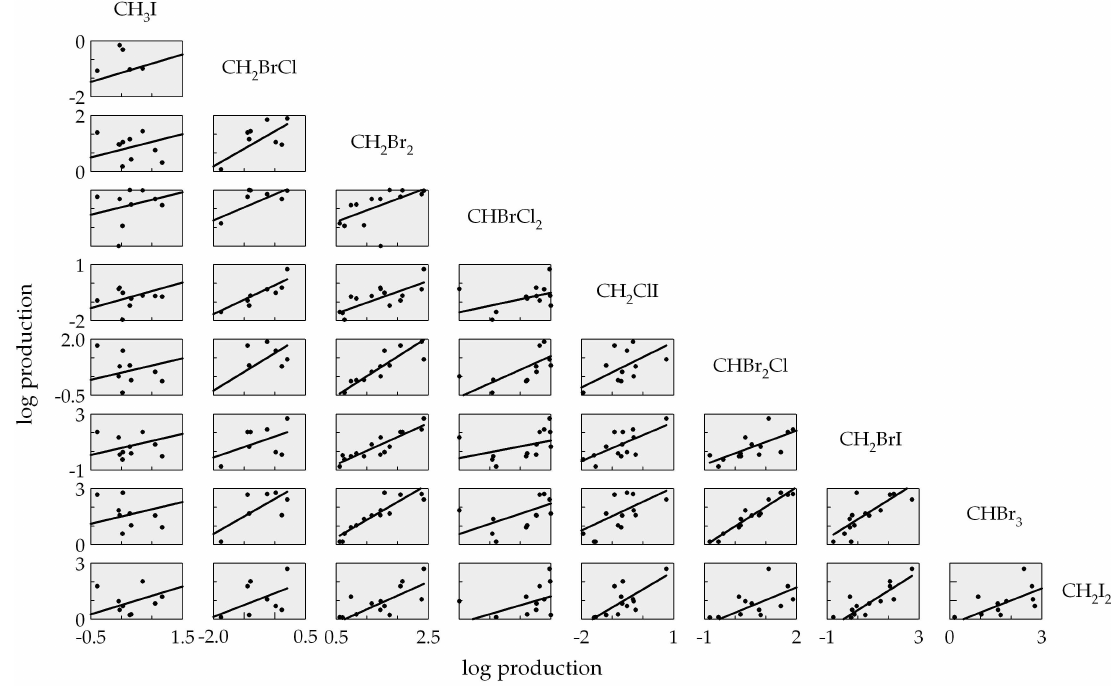
Fig. 5. Halocarbon correlation plots of log-normalised production (pmolgFW − 1 h − 1 ).